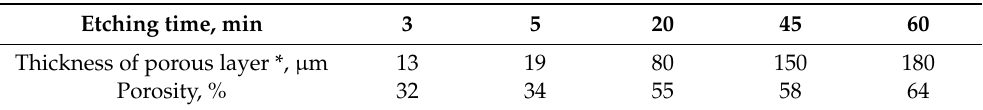
Table 1. The depth of the porous layer and the calculated gravimetric porosity of samples that were etched for different